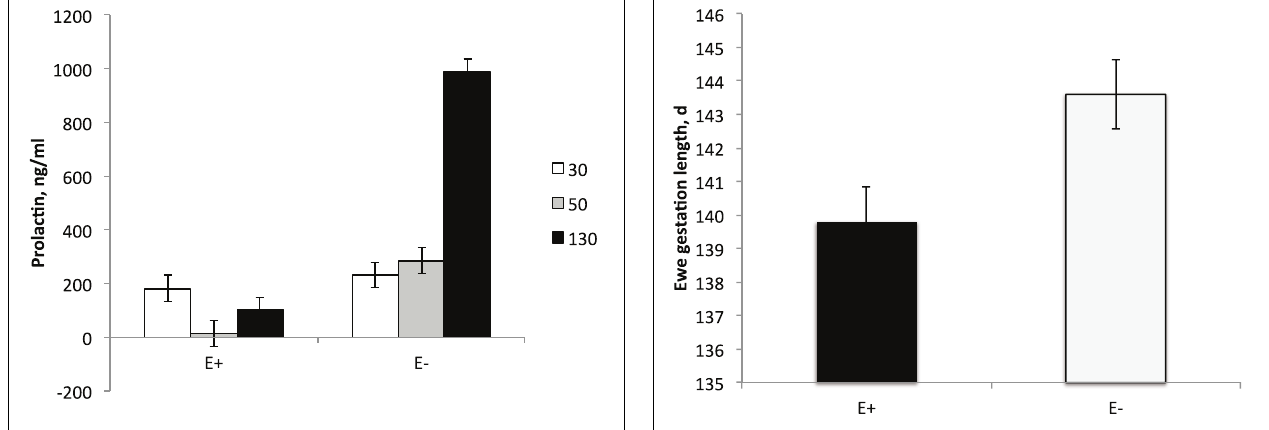
endophyte (E + ) vs. endophyte-free (E − ). Treatment was significant ( P = 0 . 02).